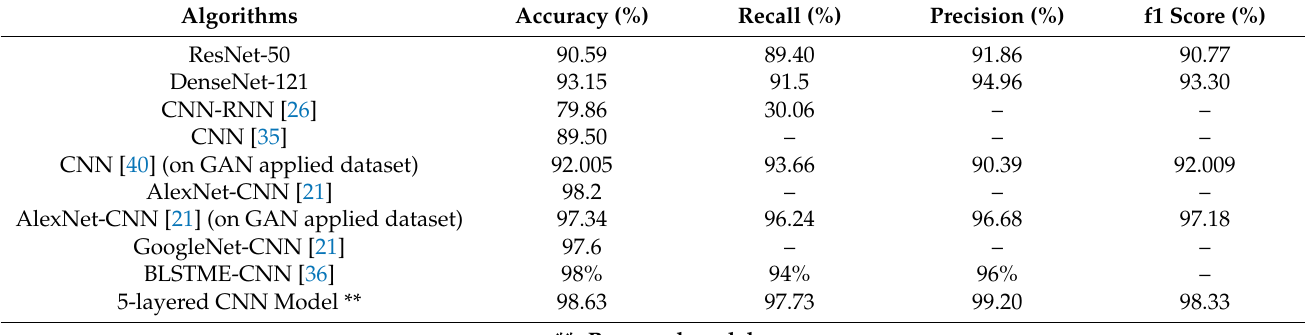
Table 5. Performance parameters of the proposed model in comparison with pre-trained